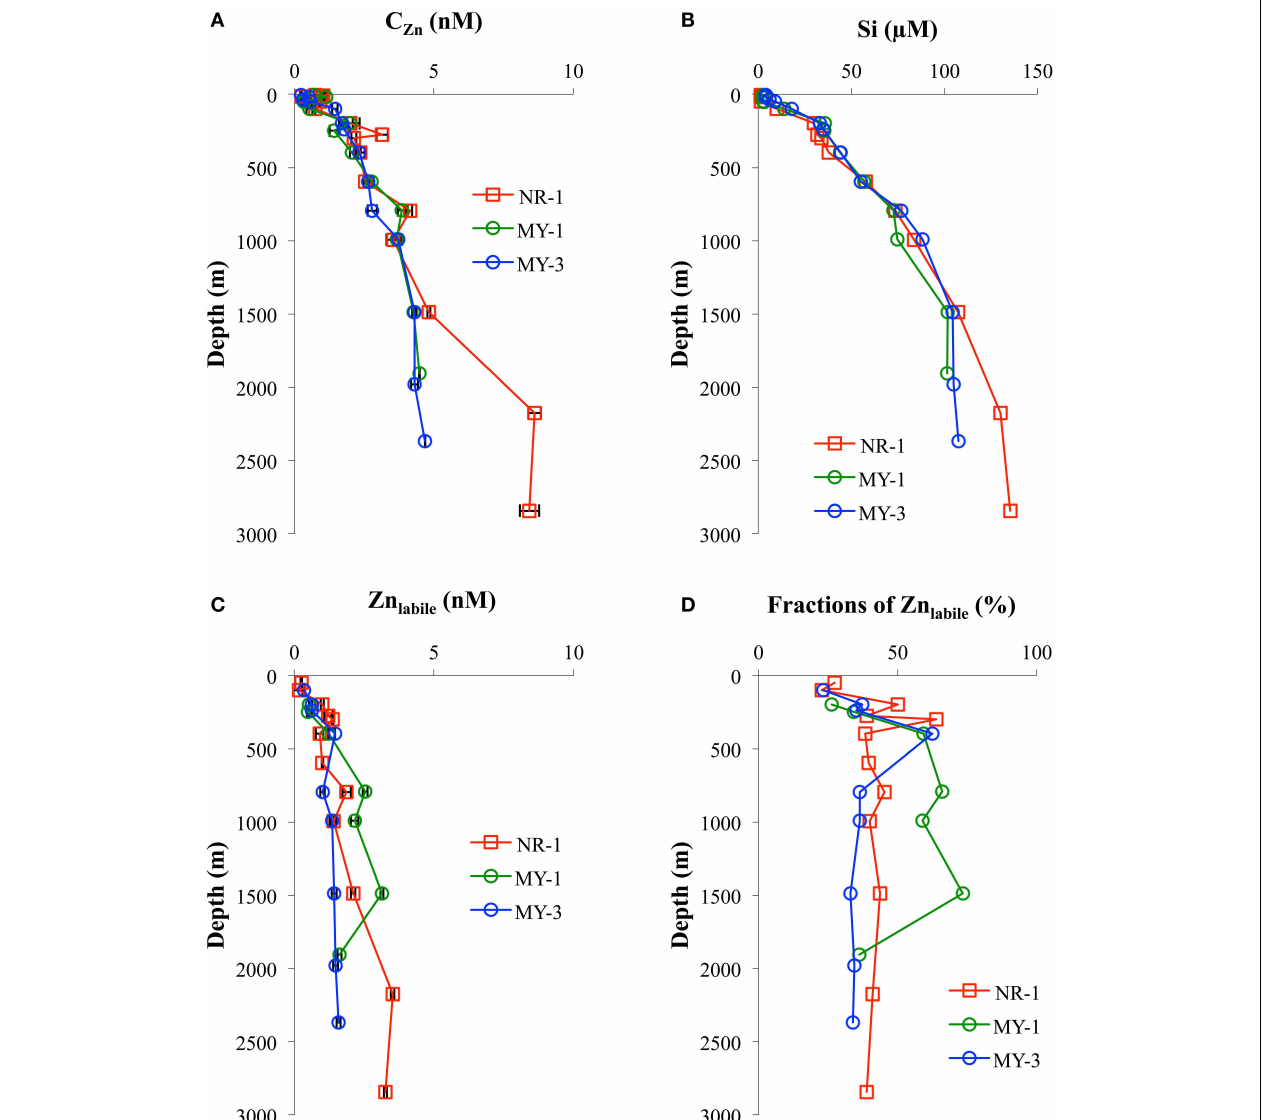
FIGURE 4 | The vertical profiles of (A) C Zn , (B) Si, (C) Zn labile , and (D) fractions of Zn labile in the northeastern Indian Ocean (NR-1) and the Andaman Sea (MY-1 and MY-3).